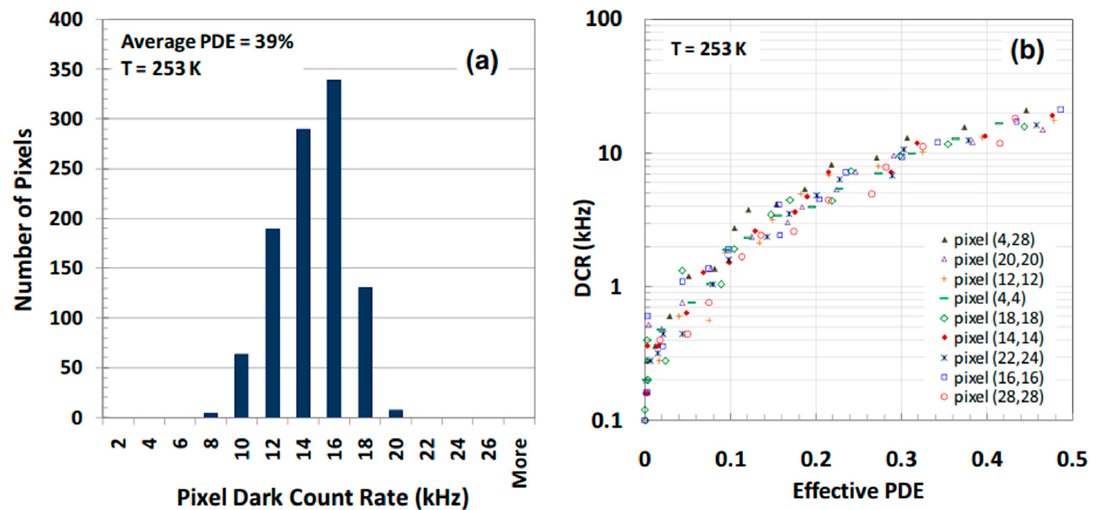
Figure 52. ( a ) Pixel DCRs distribution for the InGaAs/InP FPAs at 1.06 μ m; ( b ) SPDE-dependent DCRs. Reproduced with permission from [107], IEEE, 2010.